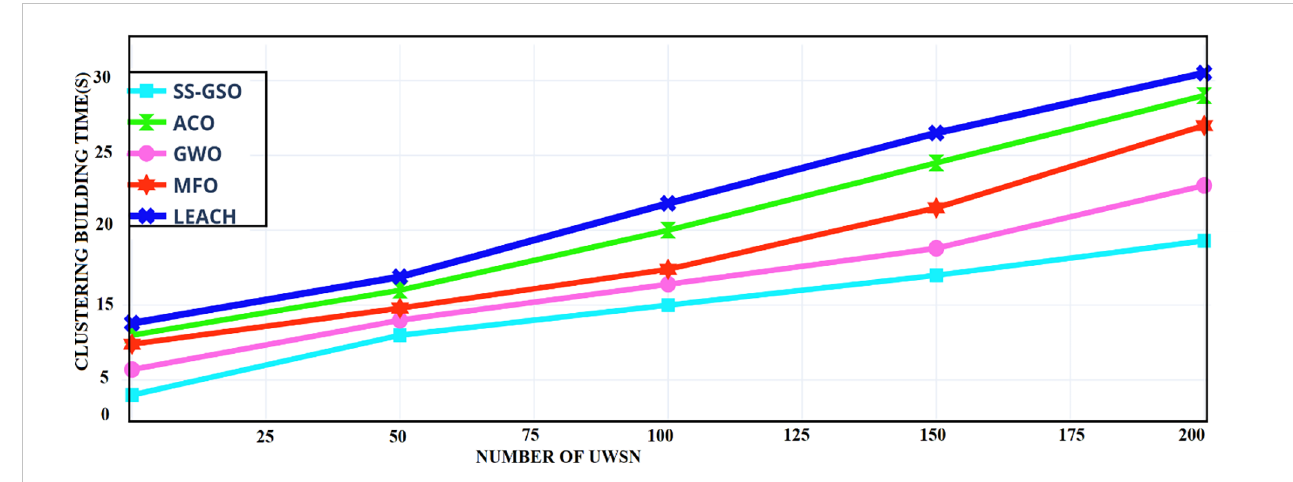
FIGURE 6 Clustering time Vs number of USWN.